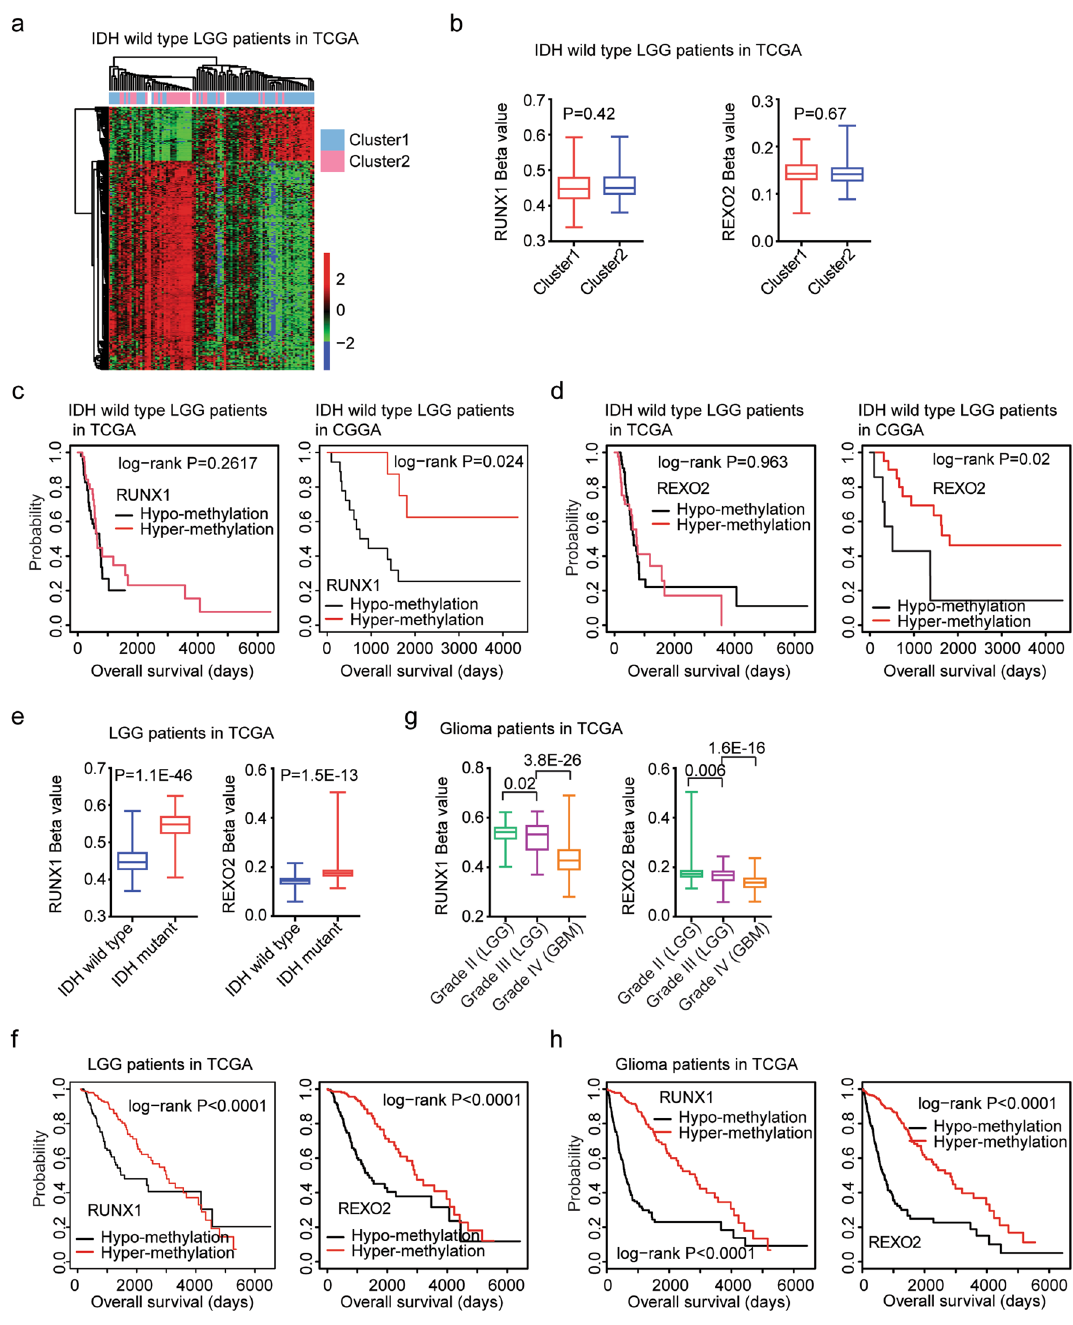
Figure 7. RUNX1 and REXO2 hyper-methylation are associated with the favorable clinical outcomes of IDH wild type LGG or LGG or glioma patients. ( a ) Un-supervised clustering heatmaps demonstrated the differentially methylated genes between sub-cluster1 and sub-cluster2 IDH wild type LGG patients in TCGA dataset. Red represented the hyper-methylated genes and blue represented the hypo-methylated genes. ( b ) Box plots showed the methylation levels of RUNX1 and REXO2 in sub-cluster1 and sub-cluster2 IDH wild type LGG patients in TCGA dataset. ( c ) The Kaplan–Meier Plotters demonstrated the different clinical outcomes of IDH wild type LGG patients with RUNX1 hypo-methylation or with RUNX1 hyper-methylation in TCGA and CGGA datasets. ( d ) The Kaplan–Meier Plotters demonstrated the different clinical outcomes of IDH wild type LGG patients with REXO2 hypo-methylation or with REXO2 hyper-methylation in TCGA and CGGA datasets. ( e ) Box plots showed the methylation levels of RUNX1 and REXO2 in LGG patients with (red) or without (blue) IDH mutations in TCGA dataset. ( f ) The Kaplan–Meier Plotters showed the correlations of RUNX1, REXO2 methylation levels and LGG overall survival in TCGA dataset. ( g ) Box plots demonstrated the methylation levels of RUNX1 and REXO2 in grade II (LGG), grade III (LGG) or grade IV (GBM) glioma patients in TCGA dataset. ( h ) The Kaplan–Meier Plotters showed the correlations of RUNX1, REXO2 methylation levels and glioma overall survival in TCGA